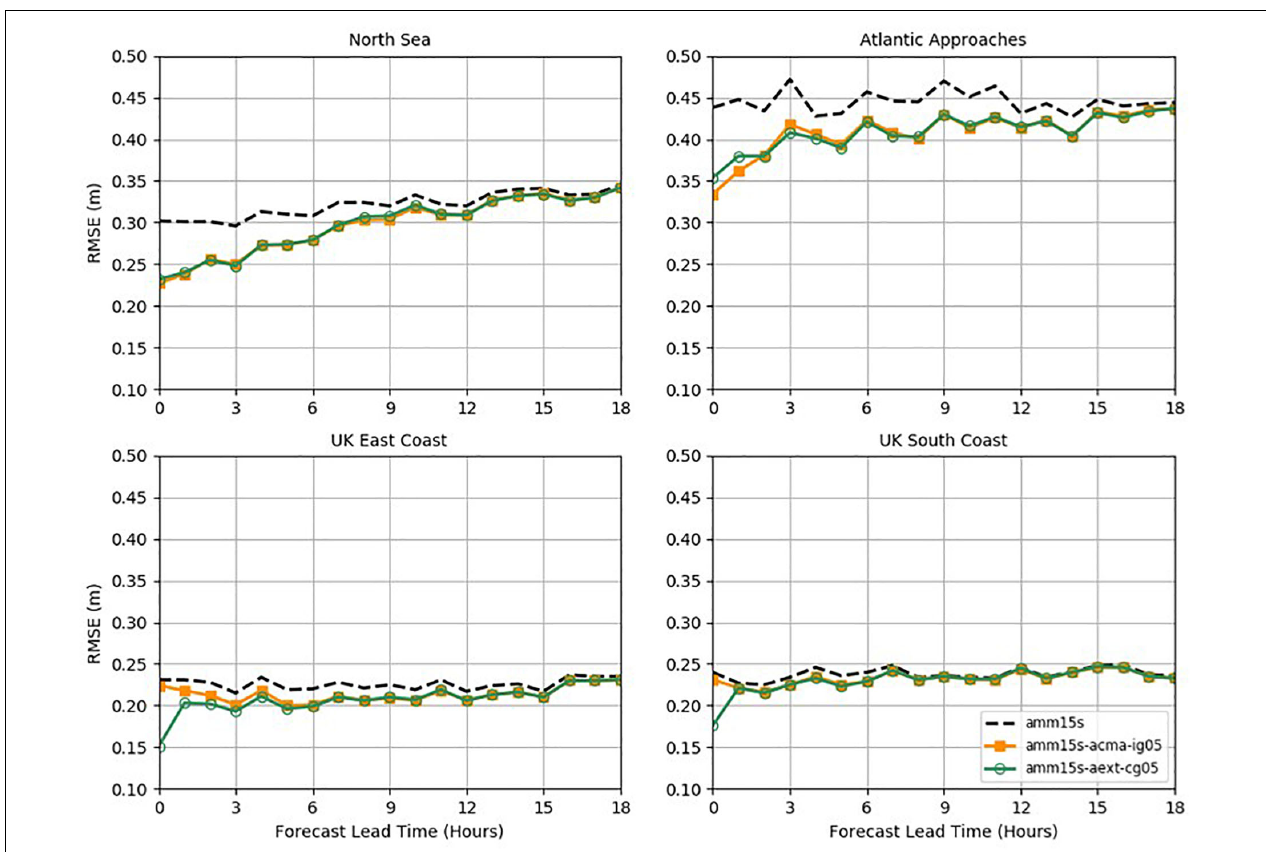
FIGURE 9 | RMSE for significant wave height predictions in the North Sea pilot case, corresponding to the North Sea domain (top left) , the Atlantic approaching area (top right) , the UK East Coast (bottom left) and the UK South Coast (bottom right) . The three analyzed numerical experiments have been inter-compared to show how they can help controlling the RMSE. Each of the panels present: model run without data assimilation (amm15s, black dashed line); model run with assimilation of satellite altimeter and in-situ wave observations in open water (amm15s-acma-ig05, gold line); model run with assimilation of satellite altimeter and in-situ wave observations covering both open and coastal waters (amm15s-aext-cg05, green